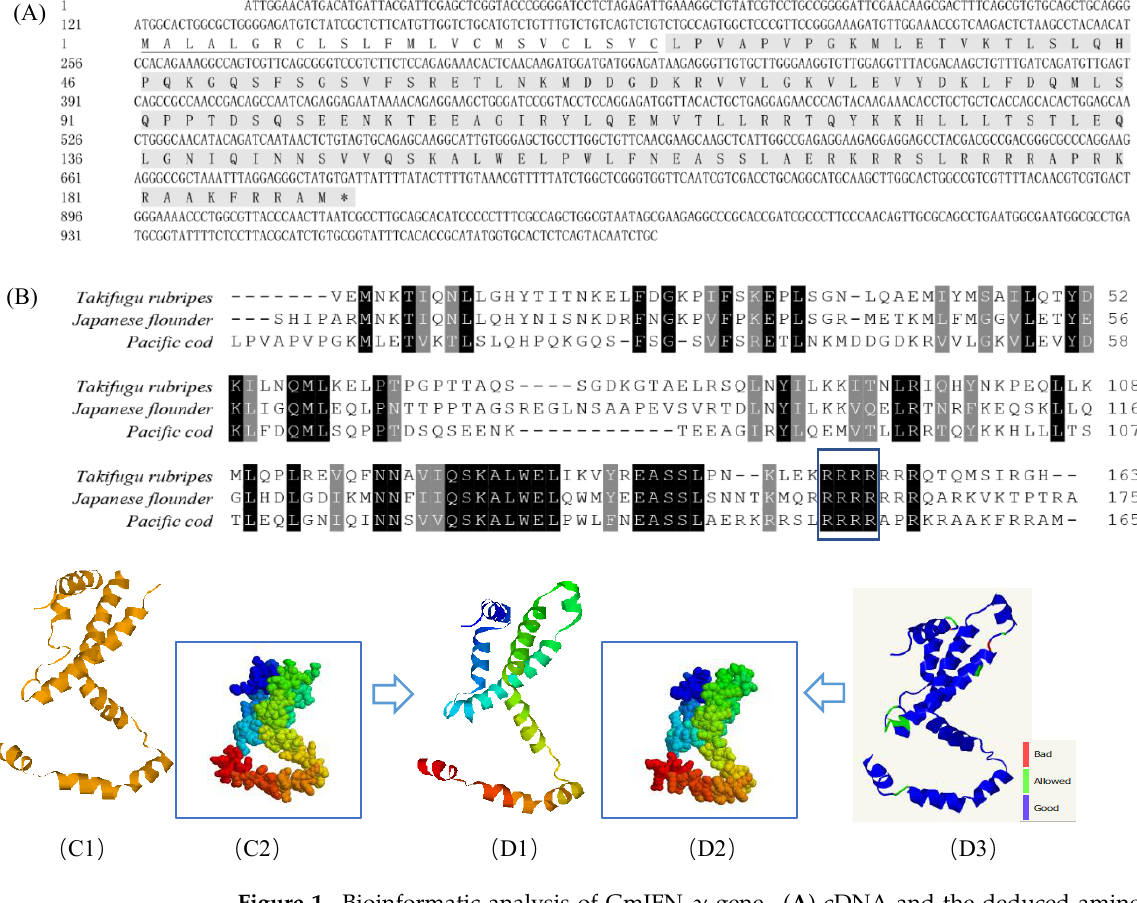
Figure 1. Bioinformatic analysis of GmIFN– γ gene. ( A ) cDNA and the deduced amino acid of GmIFN– γ . Signal peptide was underlined. ( B ) Mature IFN– γ peptides among Takifugu rubripes , Japanese flounder and G. macrocephalus were aligned. Identical or similar amino acids are shaded (black: present in all species; dark gray: present in 80% of the species). The nuclear localization signal and the putative IFN– γ signature sequence are boxed in green. ( C1 – D3 ): 3D models of IFN– γ compared between Japanese flounder and G. macrocephalus . ( C1 , C2 ): a 3D model of Japanese flounder displayed in Ribbons and Spacefill style, separately. PDB code is c6f1eA. ( D1 , D2 ): a 3D model of GmIFN– γ was constructed based on the template c6f1eA. Both were displayed in Ribbons and Spacefill style, separately. ( D3 ) Secondary structure assignment was carried using PROCHECK. Good quality is indicated in Blue, while the bad is in red.